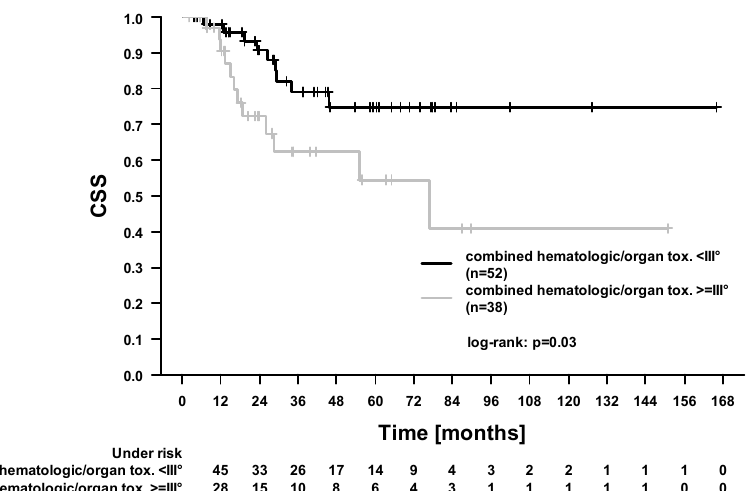
Figure 3. Cancer-specific survival (CSS). Comparison between patients who experienced hematologic and/or acute organ toxicity ≥ grade 3 and patients with toxicities <grade 3.